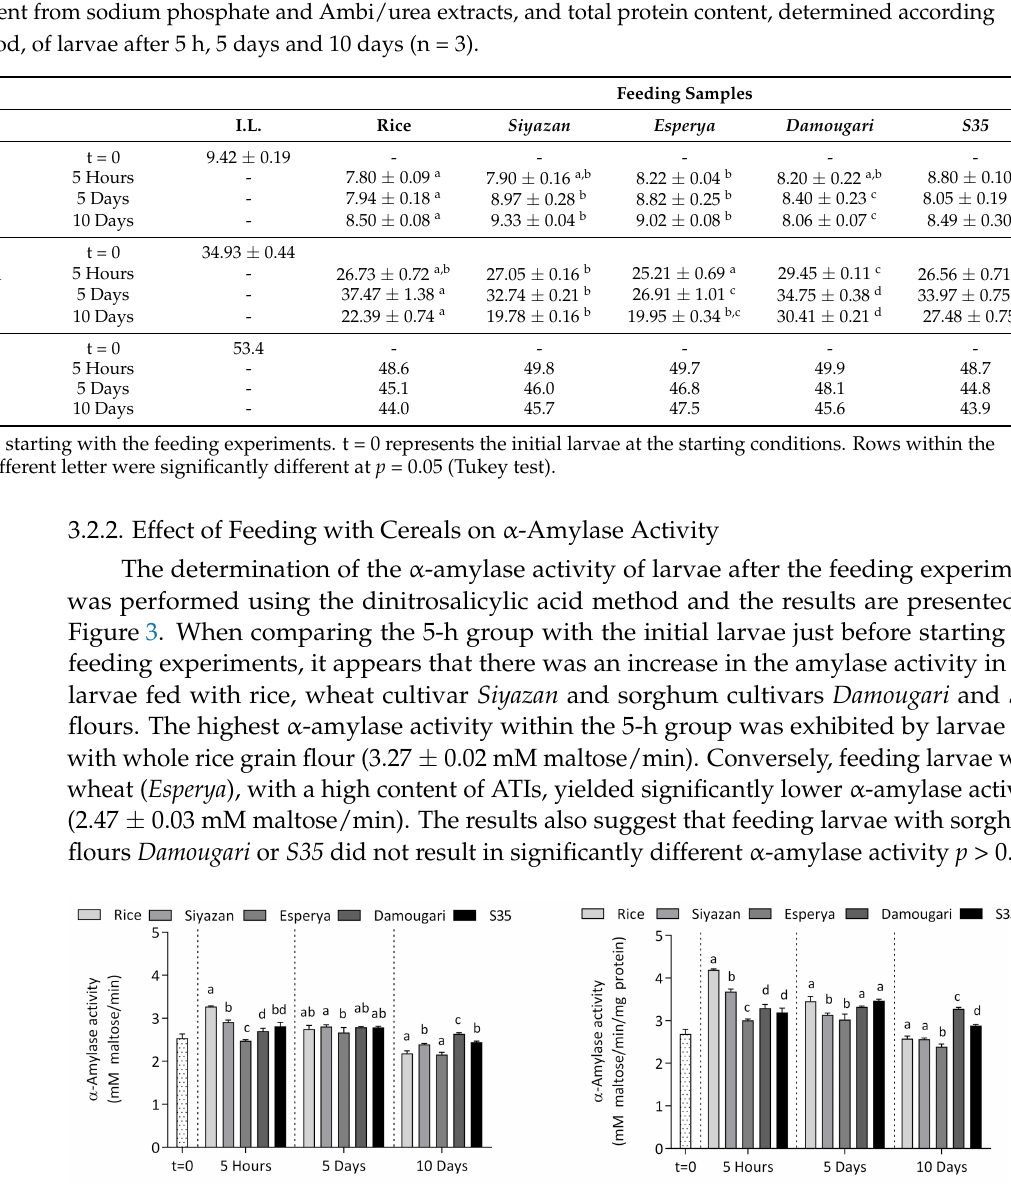
Protein content